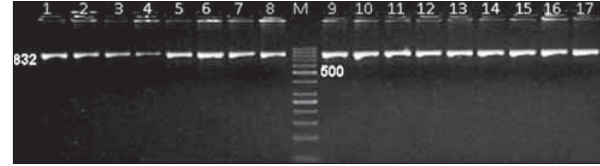
Figure-1: Polymerase chain reaction (PCR) product of 832 bp target region of cluster of differentiation 14 gene in Karan fries cows